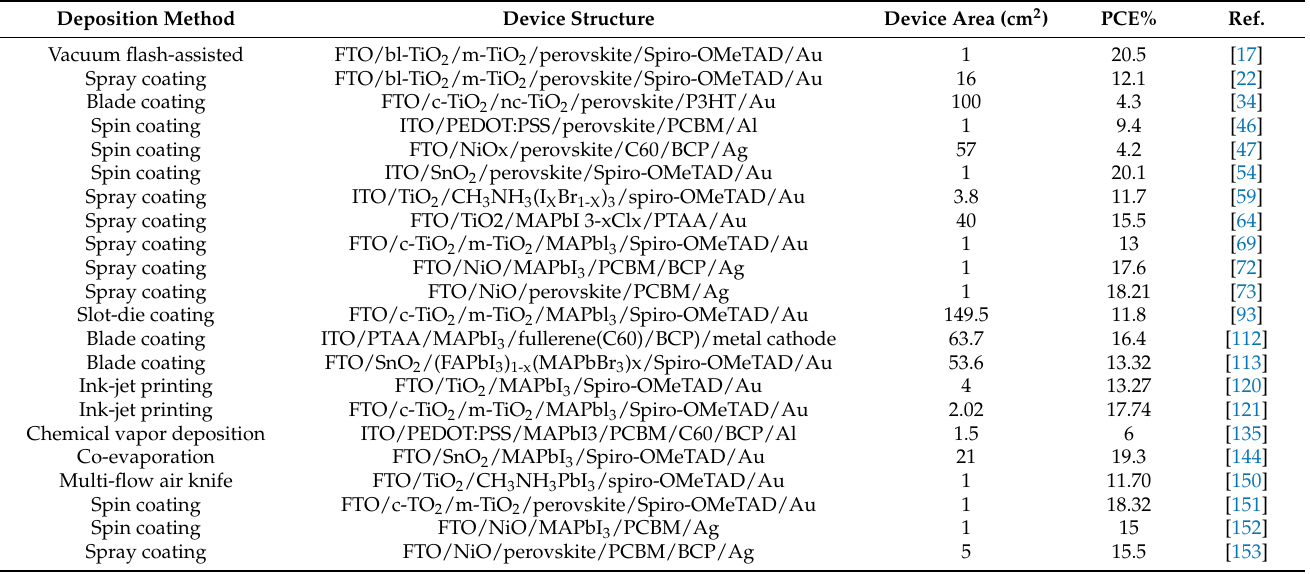
Table 2. Summary of published applications of various thin film deposition methods in the fabrication of large-area PSCs, with device areas ≥ 1 cm 2 , discussed in this